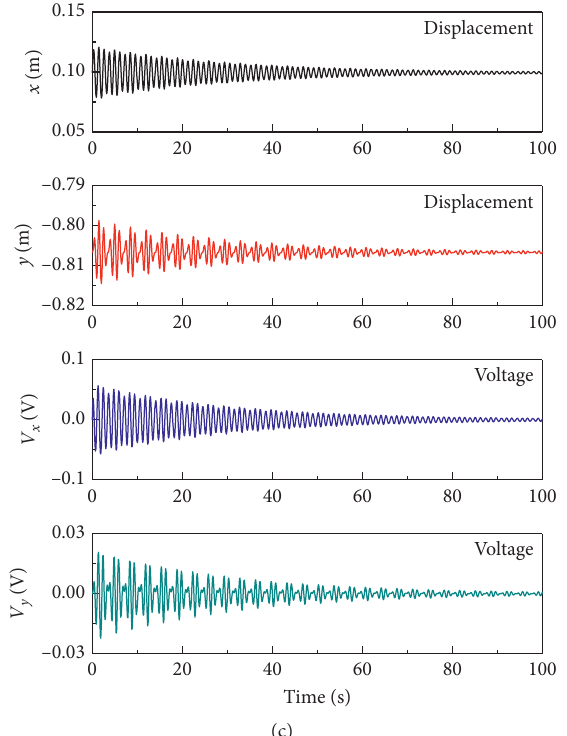
Figure 21: Ignoring separation, the displacement and output voltage of the friction system when the normal load is F � 20N (a), F � 70N (b), and F � 120N